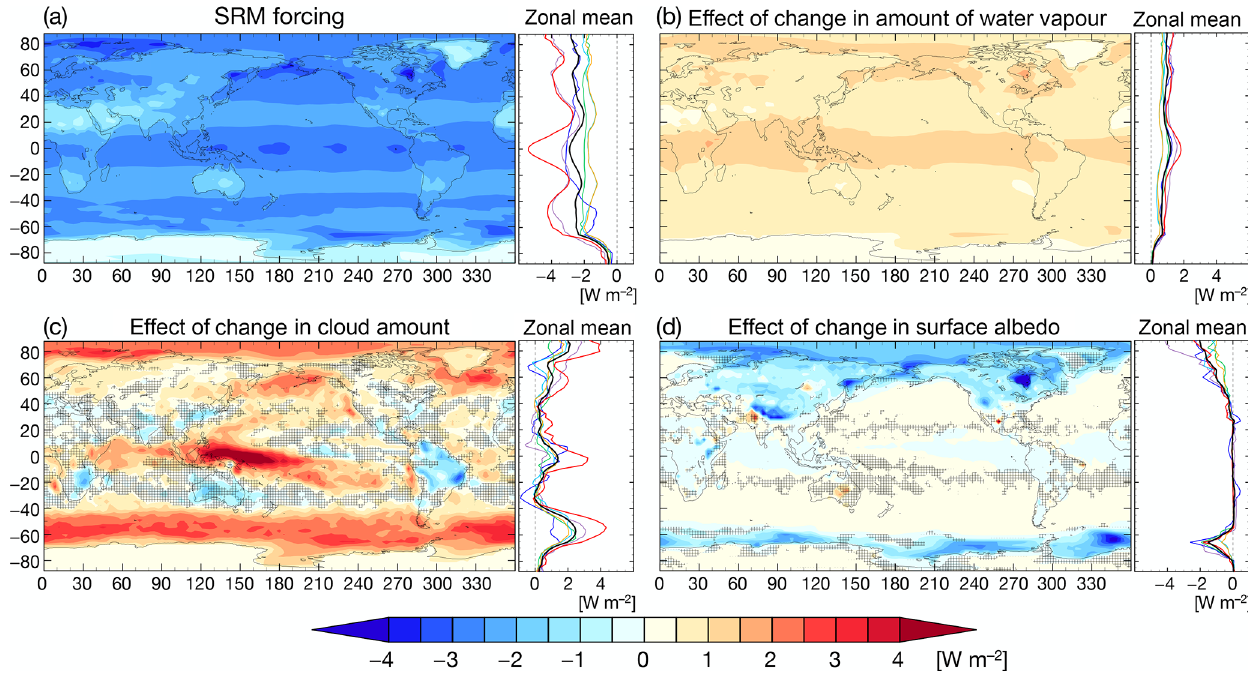
Figure 9. Same as Fig. 8 but for multi-model mean of (a) SRM forcing, SW total reactions due to changes in the (b) water vapour amount, (c) cloud amount, and (d) surface albedo, averaged over